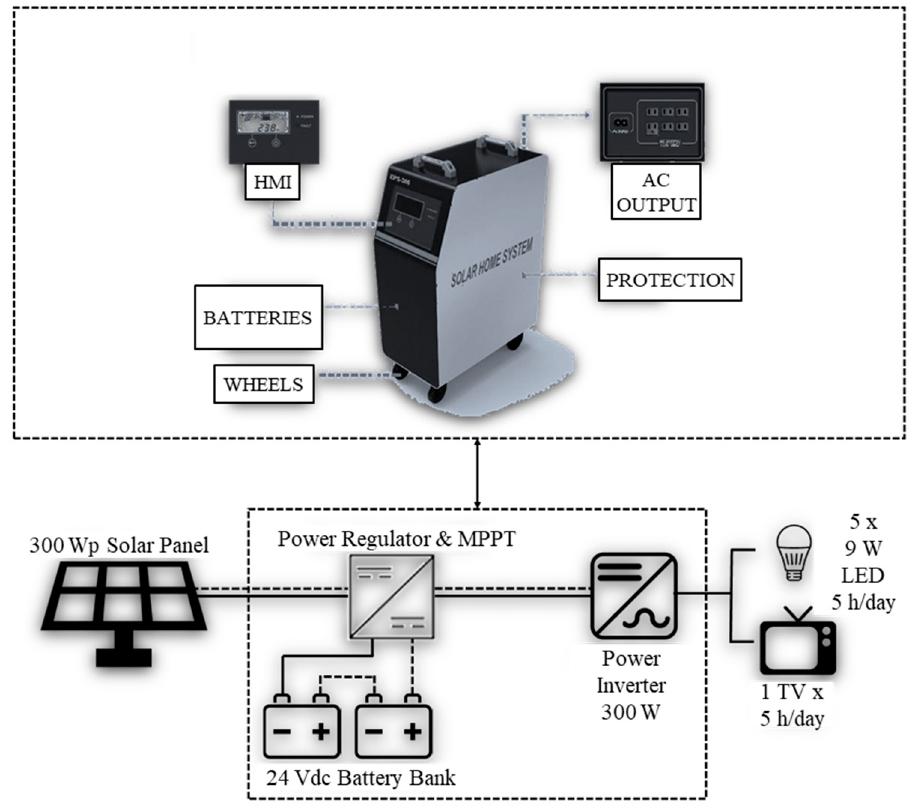
Figure 5. Electrical scheme of a modular solar system installed in R í o Abajo. Currently, R í o Abajo is a community of 50 houses. The young inhabitants travel during the week to study in the nearest cities, while the elders stay within the community working in agriculture and livestock. The most widespread products are onions and bananas, which are gathered in the community center and then sold to the most important cities and population centers in the province of Sancti Spiritus. The MPS is totally portable, so there is no need for excessive wiring in the houses, and the panels are installed on the roof (Figure 6). The visual impact of the panels is very limited, since they can be installed on the roof of the houses without needing additional buildings or infrastructure. In addition, note that although the roof structure might seem weak to support the panels’ weight, no issues in this regard were reported during the field visits. The operation and maintenance are carried out by the state-owned Cuban electricity company. The houses are scattered over an area of 180 ha (1.8 km 2 ). The area has a length of 2.5 km and a maximum width of 900 m and extends alongside a small river that leads to a reservoir used for irrigation. Therefore, a low-voltage diesel or RET-based microgrid would have voltage regulation problems due to the long distances between houses, so only domestic electrification is